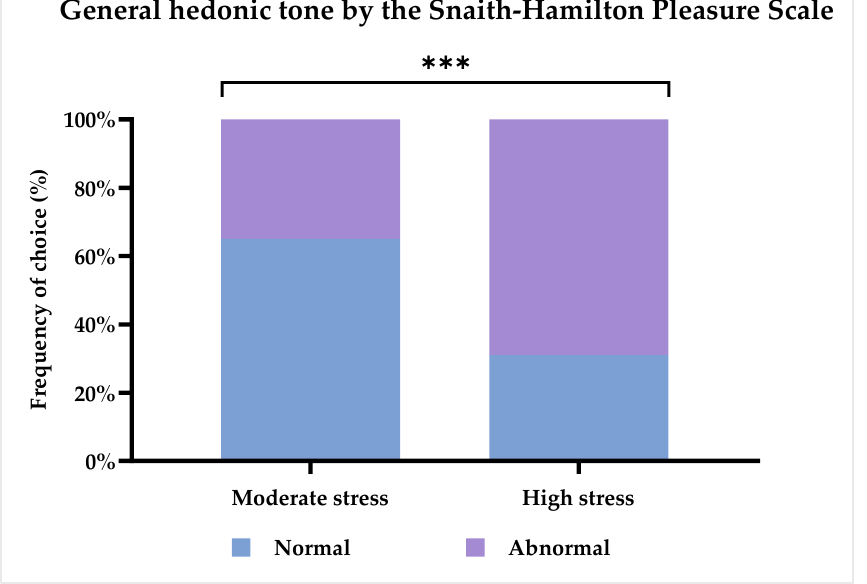
Figure 3. General hedonic tone by measure of the Snaith – Hamilton Pleasure Scale. Results are shown for the two groups based on the results of the PSS-10: ‘Moderate stress’ ( n = 116) and ‘High stress’ ( n = 74). Stars indicate level of significance of p -values. *** p < 0.001 .